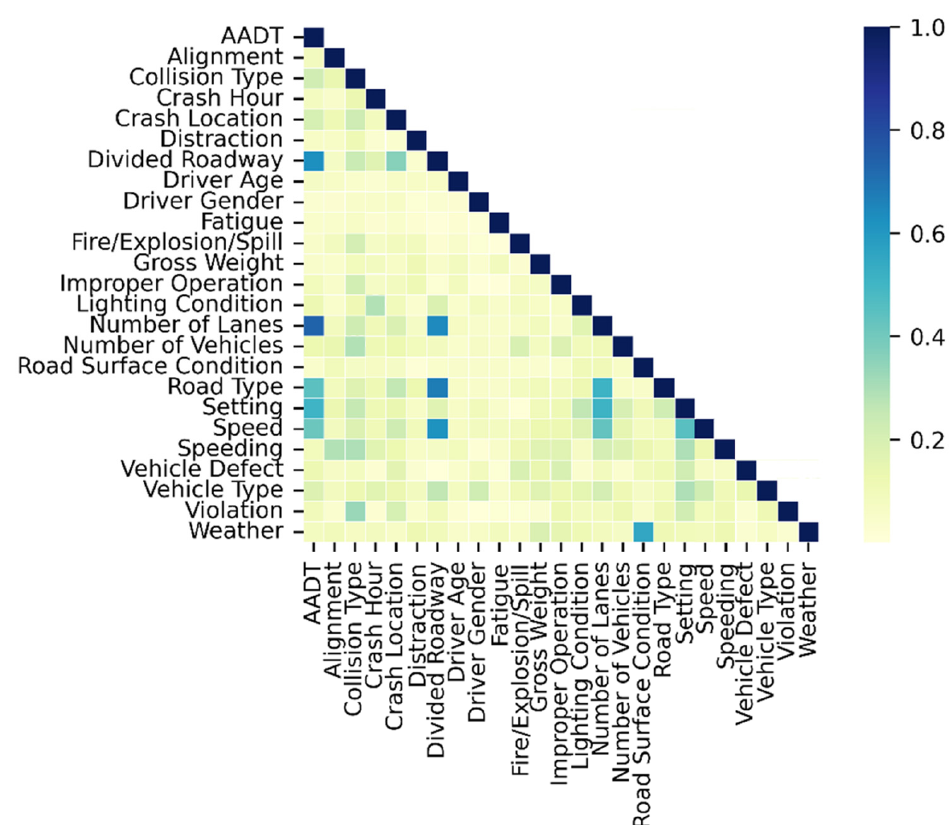
Figure 1. Variable correlation matrix.